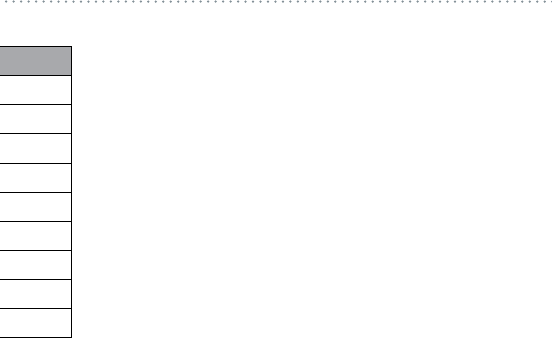
Table 4. First cell focal point.